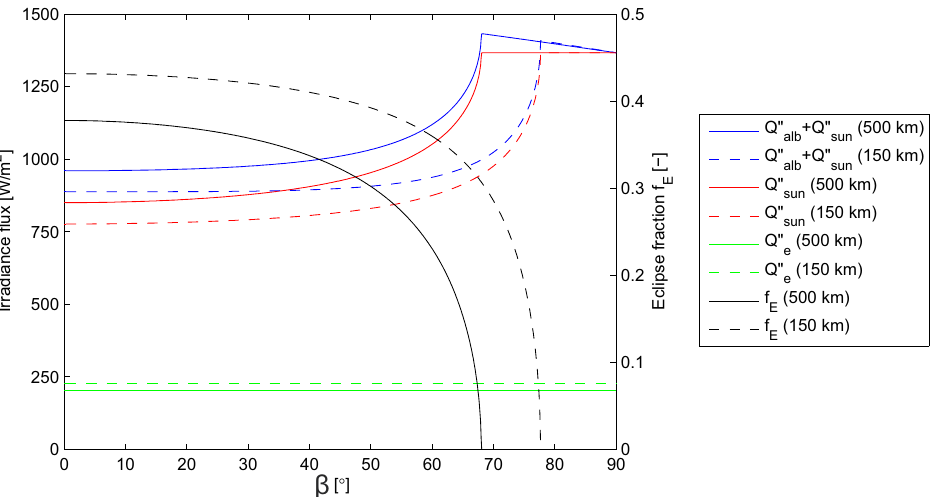
Figure 6. Irradiance sources and eclipse fraction as function of β . The solid lines (—) are valid for the altitude of 500 km and the dashed lines (- -) are for an altitude of 150